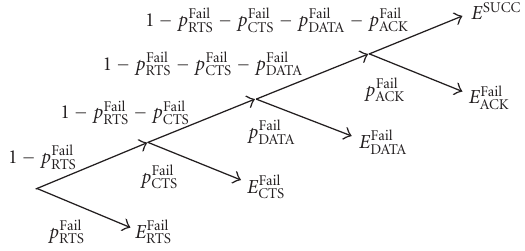
Figure 3: Binary event tree of frame failure and energy